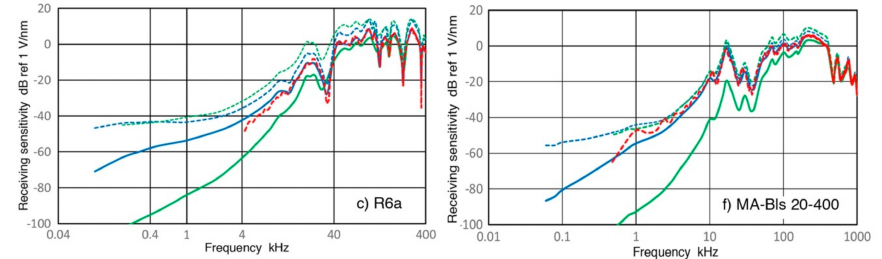
Figure A1. ( a ) Receiving displacement sensitivity spectra are shown against log-frequency (in kHz) for V192 (1.0) transducer in dB in reference to 1 V/nm using two Z in of 1 M Ω (blue) and 10 k Ω (green). Corresponding pulse sensitivity spectrum is in red dash curve and calculated open-circuit sensitivities are in blue dot (using data of Z in of 1 M Ω ) and in green dot (10 k Ω ) curves; ( b ) Same for V103 (1.0); ( c ) Same for R6a (0,06); ( d ) Same for MA-Bls 40–100; ( e ) Same for MA-Bls 30–200; ( f ) Same for MA-Bls 20–400.